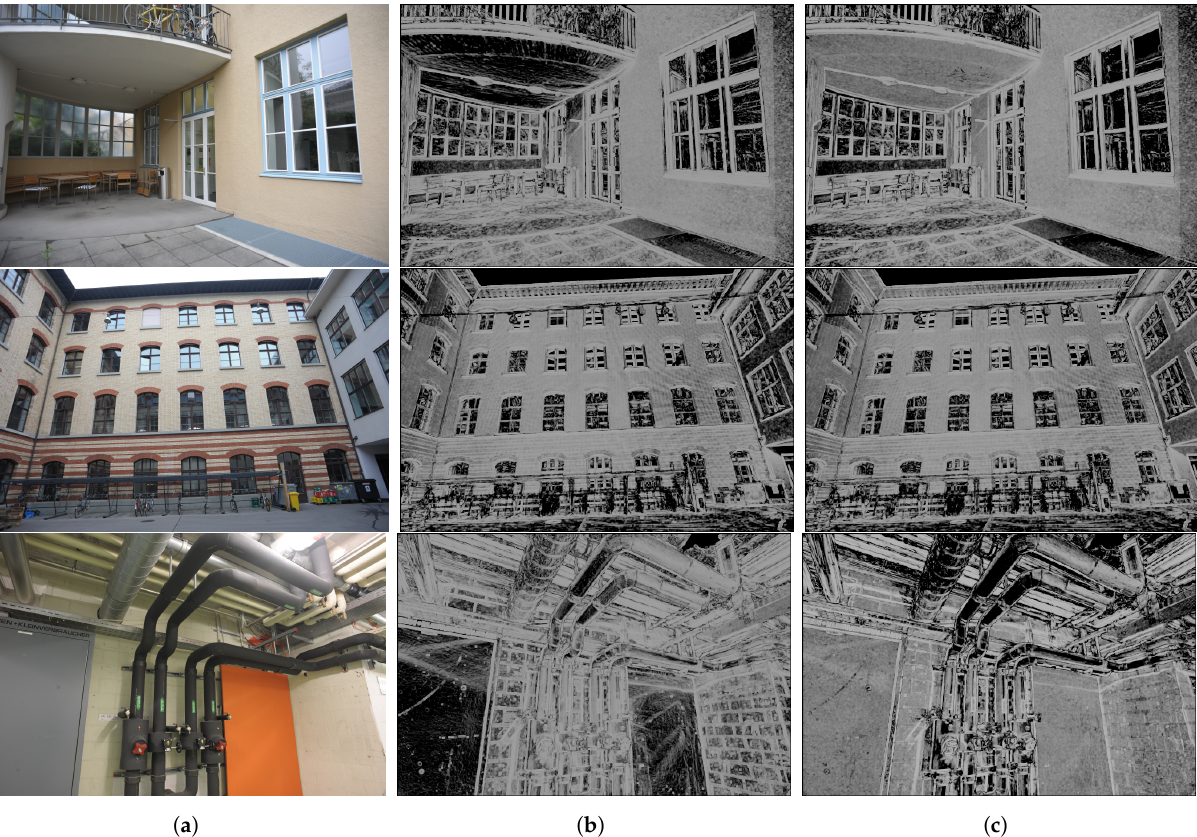
Figure 6. Qualitative confidence map comparison of our method with respect to the baseline OpenMVS on the ETH3D datasets. Scale black to white, where black means lower confidence. It is evident that the plane priors increase the confidence, especially where textureless areas are present in ETH3D-terrace (ceiling) and ETH3D-pipes (orange panel, closet). For ETH3D-courtyard where the not particularly textureless areas exist, the confidence remains mostly the same. ( a ) RGB image; ( b ) OpenMVS; ( c )